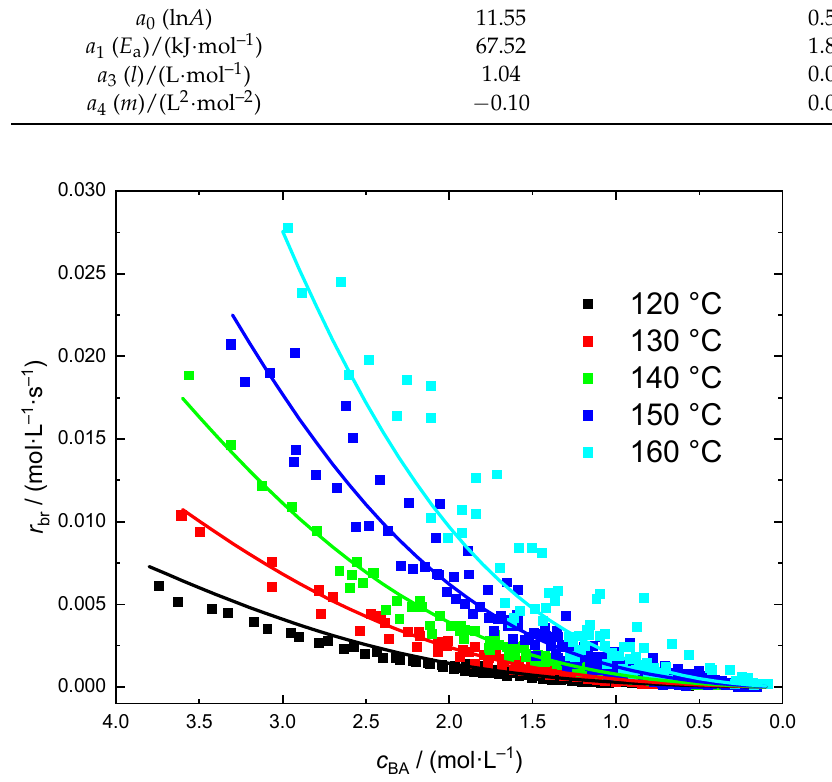
Figure 7. r br data obtained for polymerizations ranging from 120 to 160 ◦ C. The lines were calculated according to Equation (11) with the parameter set given in Table 3.